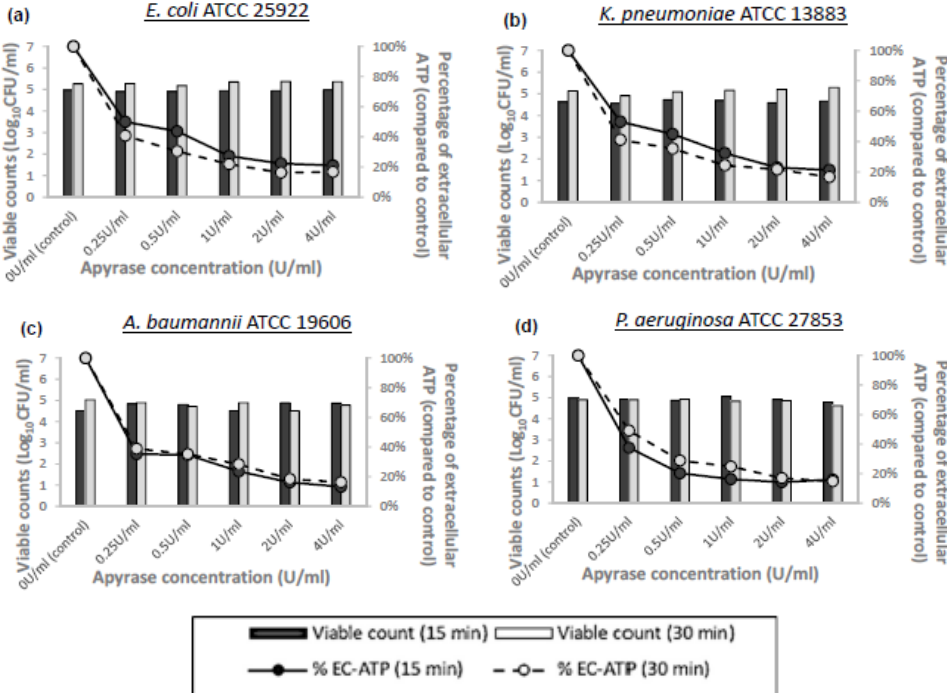
Figure 1. E ff ects of varying apyrase concentrations (U / mL) and incubation times on average viable